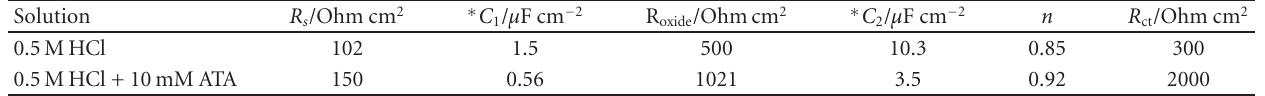
Table 2: Results of capacitance and resistance values from impedance measurements at 298K.